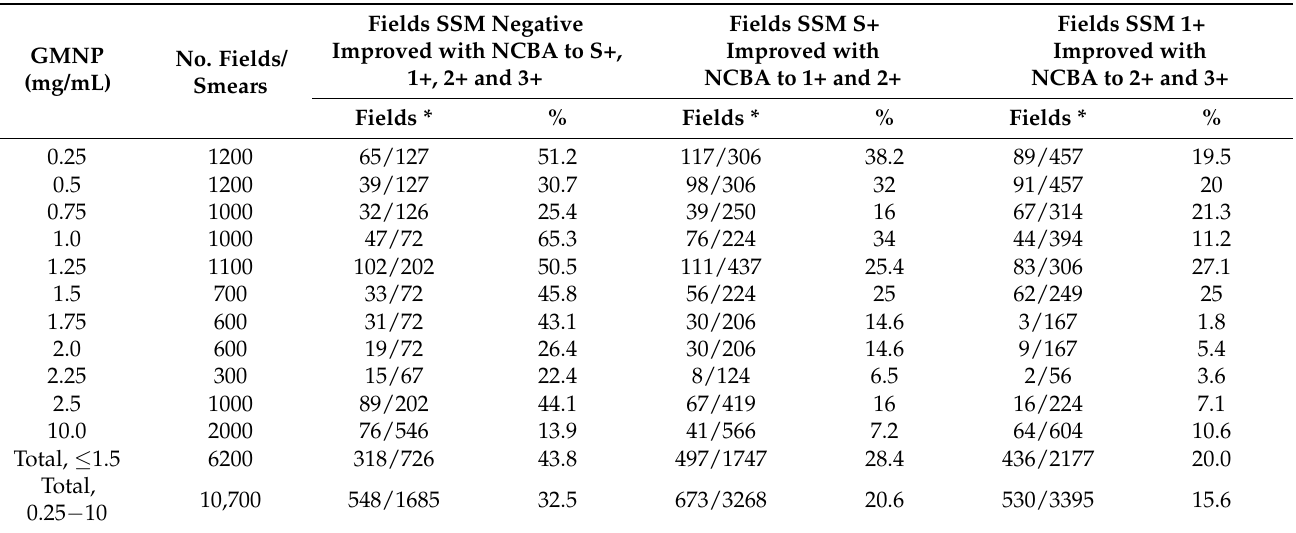
Table 3. Proportion of SSM smear fields ( n = 3000) improved by NCBA in sputum samples from people with pulmonary